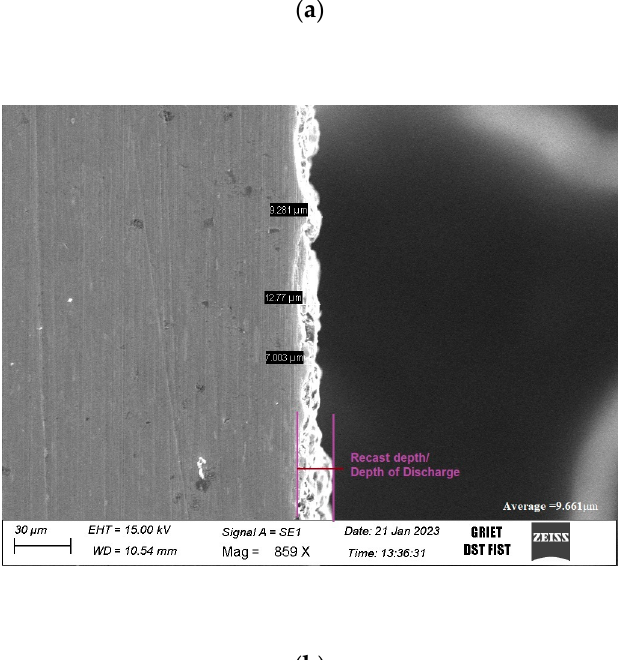
Figure 4. Recast layer on work surface with various electrodes. ( a ) Untreated electrode. ( b ) Treated electrode.